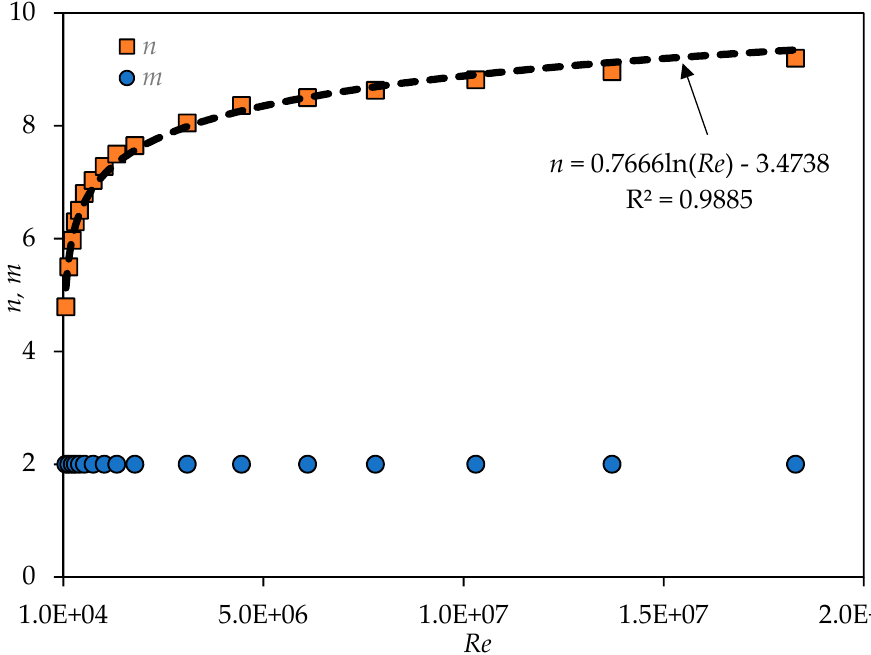
Figure 13. Developing a correlation between the parameter n and Re (for a range of Re between, approximately, 1 × 10 4 and 2 × 10 7